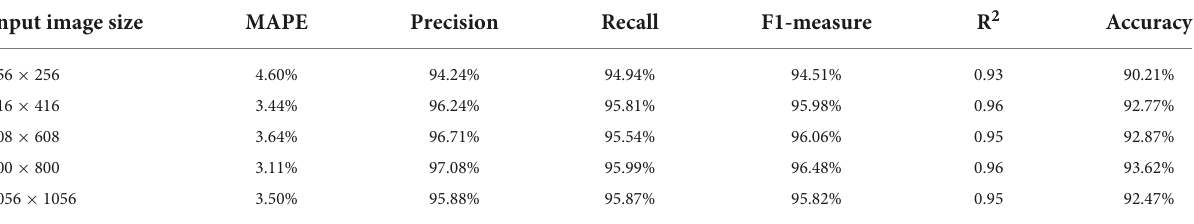
TABLE 3 Comparison of the different input size/spatial resolution for the PanicleDetect